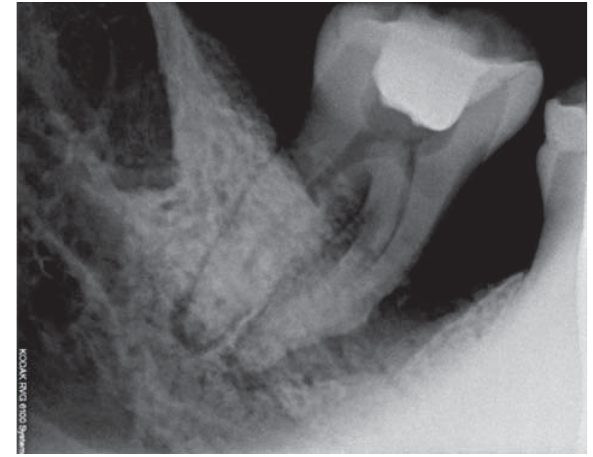
Figure 1- Radiographic image of tooth with periodontal endodontic lesion